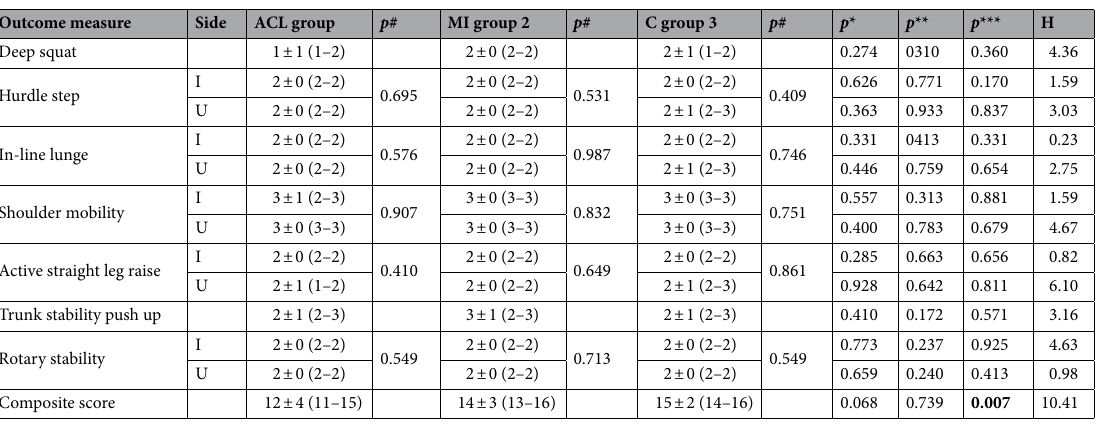
Table 2. Comparison of Functional Movement Screen variables between study groups. Values are expressed as median ± quantile range (lower quantile– upper quantile) of points from FMS test. H, Kruskal–Wallis test value between study groups. p * p value between ACL group and MI group (the p value there is the post-hoc of study groups main effect). p ** p value between MI group and C group (the p value there is the post-hoc of study groups main effect). p *** p value between ACL group and C group (the p value there is the post-hoc of study groups main effect). p# p value between involved (I) and uninvolved (U) side within each